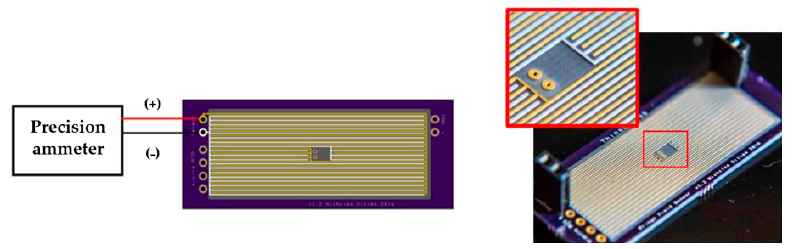
Figure 27. Sensor figures (ENIG and zinc coating indicated by gold and white traces) (Reprinted with permission from Ref. [204]. Copyright 2020 Taylor & Francis Group, LLC).